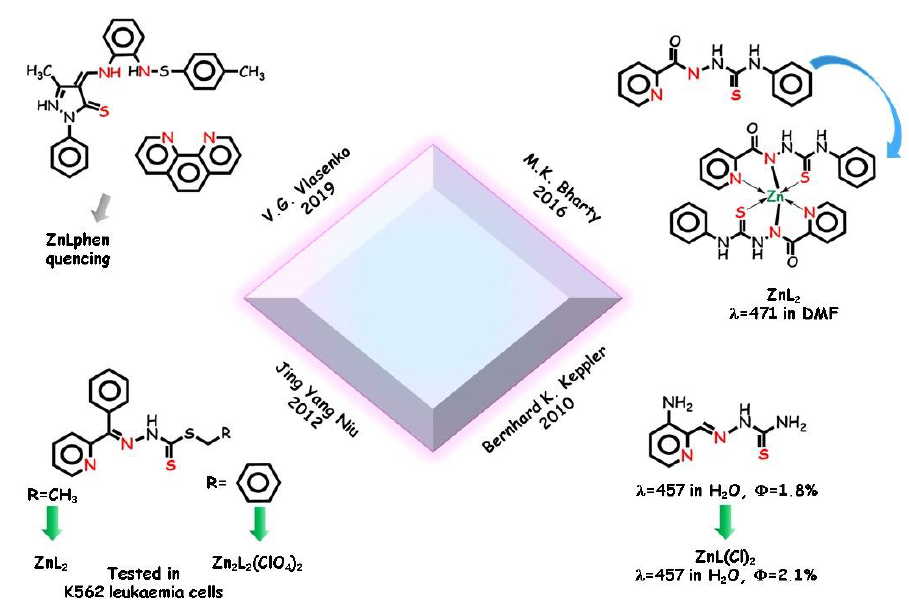
Figure 11. Selected example of N , N , S tridentate pincers and their complexes.